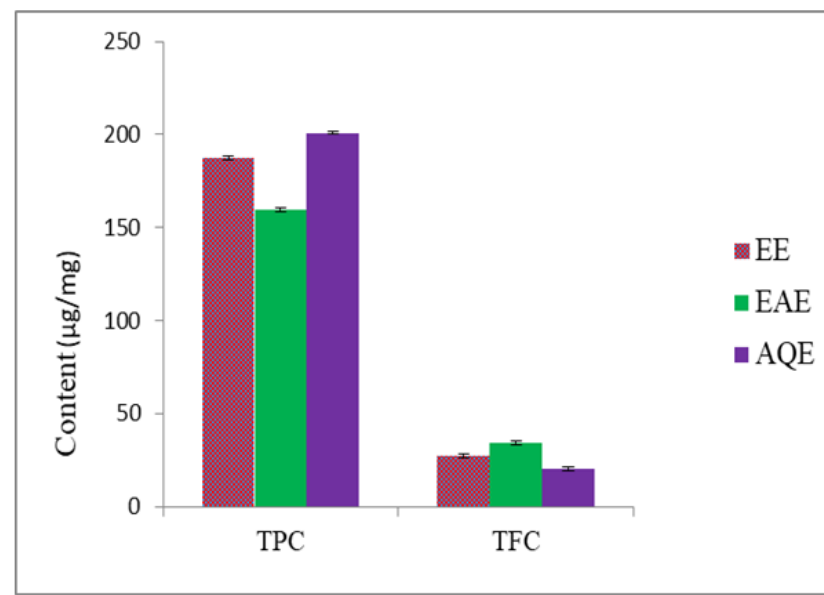
FIGURE 5 - Polyphenol content (TPC and TFC) in different extracts of seed of N. arbor-tristis